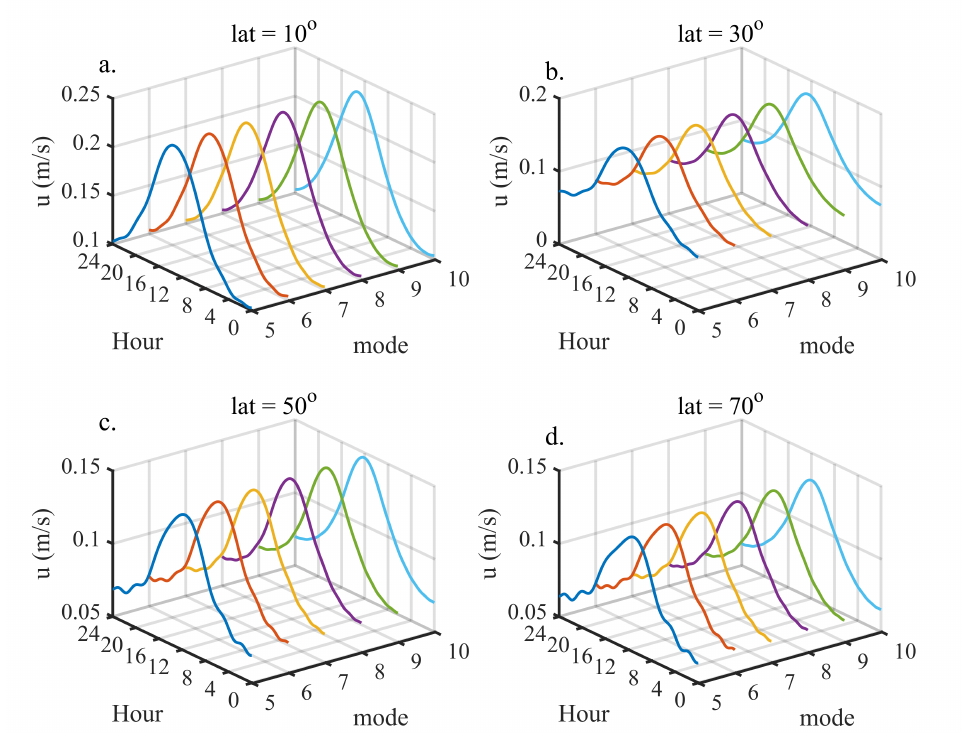
Figure 3. Mode dependence of surface zonal velocity u 0 at ( a ) lat = 10 ◦ , ( b ) lat = 30 ◦ , ( c ) lat = 50 ◦ , ( d ) lat = 70 ◦ , assuming δ =